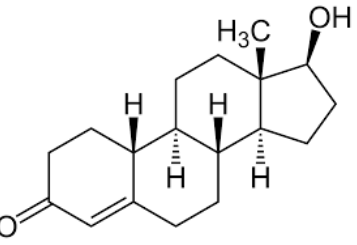
Figure 30. Chemical structure of nandrolone. Formula: C 18 H 26 O 2.